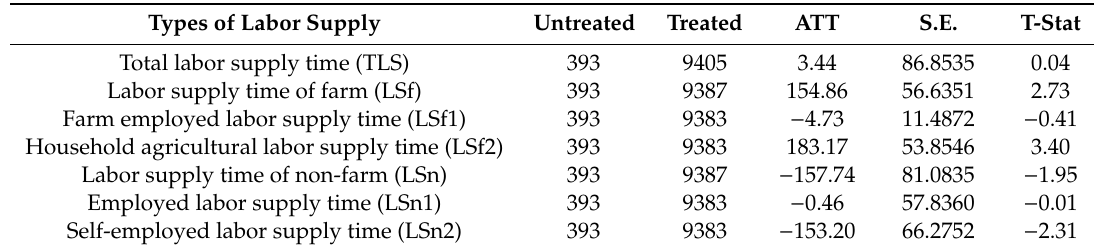
Table 13. ATT of health insurance to labor supply